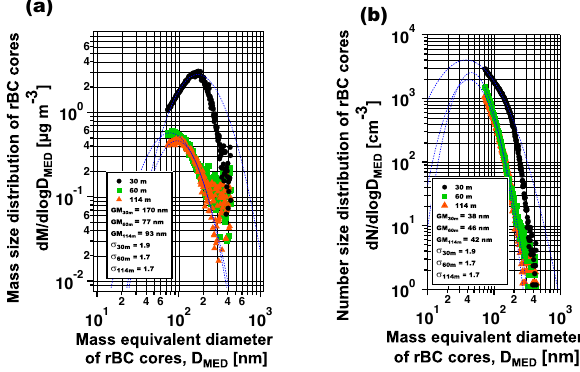
Figure 3. rBC (a) mass and (b) number size distributions. Values are shown for measurements at 30m (100ft.), 61m (200ft.), and 114m (375ft.) downwind of Interstate 405 in Los Angeles, Califor- nia. Lognormal fits and their corresponding geometric means (GM) and standard deviations ( σ ) are shown for each distance.